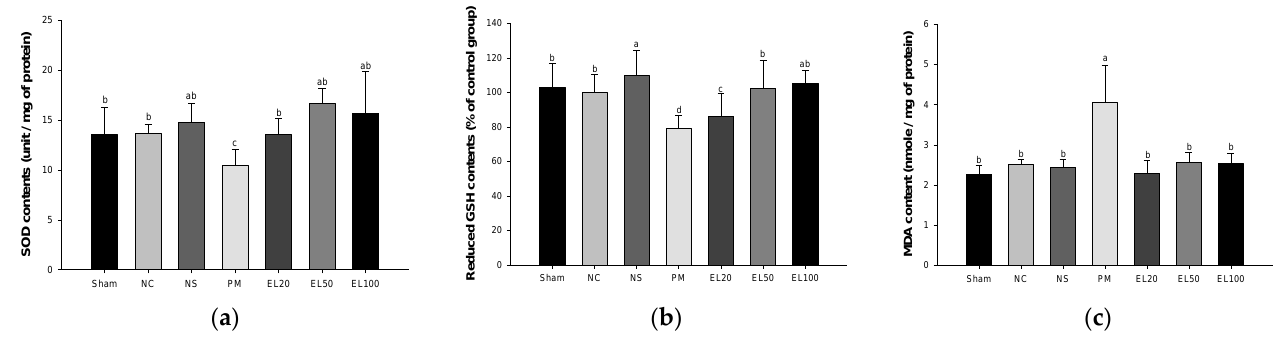
Figure 4. Protective effect of extract of Lonicera japonica on PM 2.5 -induced biochemical changes related to the antioxidant system. ( a ) Superoxide dismutase (SOD) contents; ( b ) Reduced glutathione (GSH) contents; ( c ) Malondialdehyde (MDA) levels. Results shown are mean ± SD ( n = 5). Data were statistically represented at p < 0.05, and different lowercase letters indicate statistical significance.